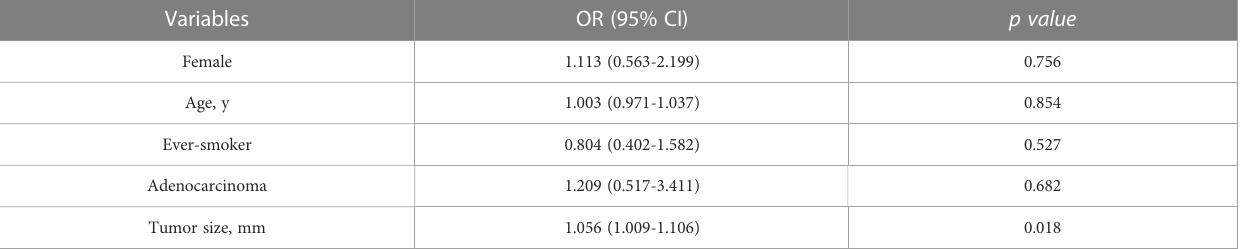
TABLE 3 Firth ’ s bias-reduced logistic regression analysis assessing predictors of isolated brain metastasis in participants who underwent brain MRI. Variables